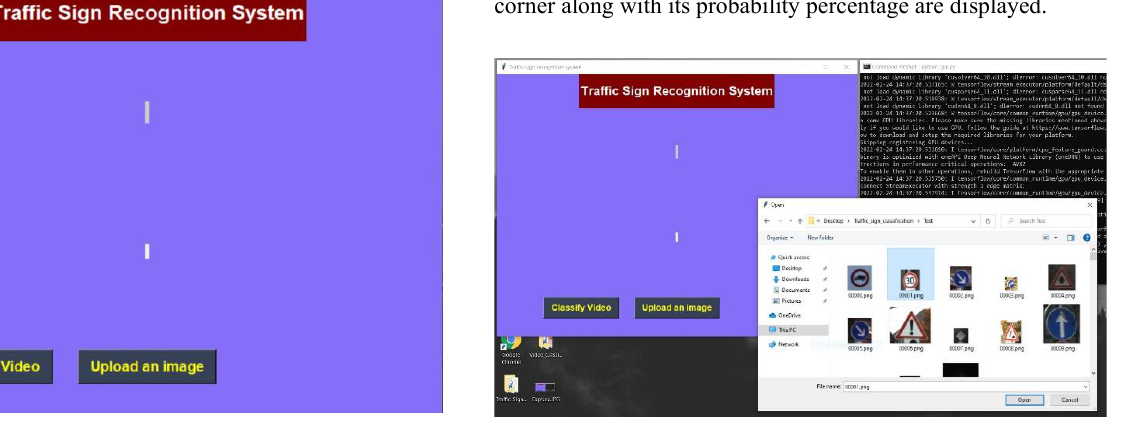
Fig. 15.1 GUI Of proposed System